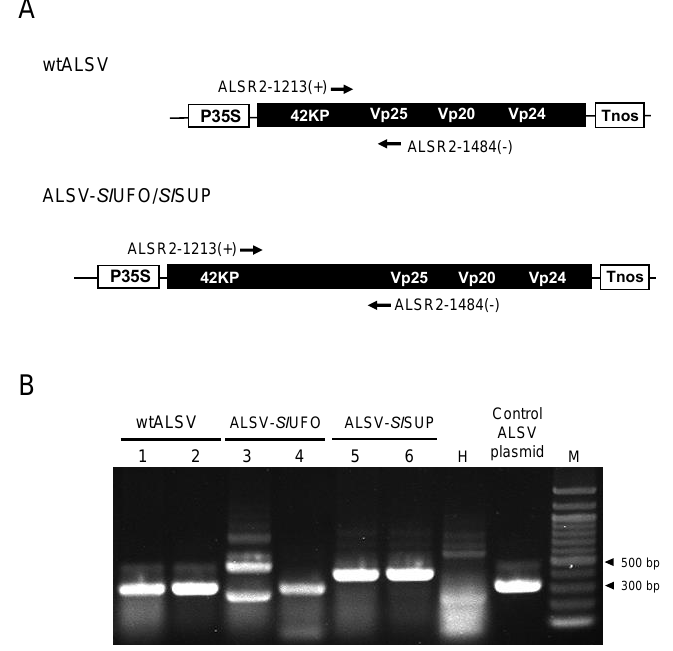
Figure 5. Verification of ALSV infection and the retention of the insert in ALSV- Sl UFO and - Sl SUP plants. ( A ) Schematic representation of wtALSV and ALSV- Sl UFO/ Sl SUP. The insert size is 162 and 132 bp for ALSV- Sl UFO and Sl SUP, respectively. Arrows indicate a primer set flanking the insert used for RT-PCR; ( B ) representative result of the RT-PCR in the flower buds inoculated with wtALSV (Lane 1 and 2), ALSV- Sl UFO (Lane 3 and 4), and ALSV- Sl SUP (Lane 5 and 6). The size of the amplification products from wtALSV, which has no insert, is approximately 300 bp. The retention of the insert was determined by the fragment length. H, uninfected healthy plant; control ALSV plasmid, the ALSV plasmid without the insert; M, 100 bp ladder